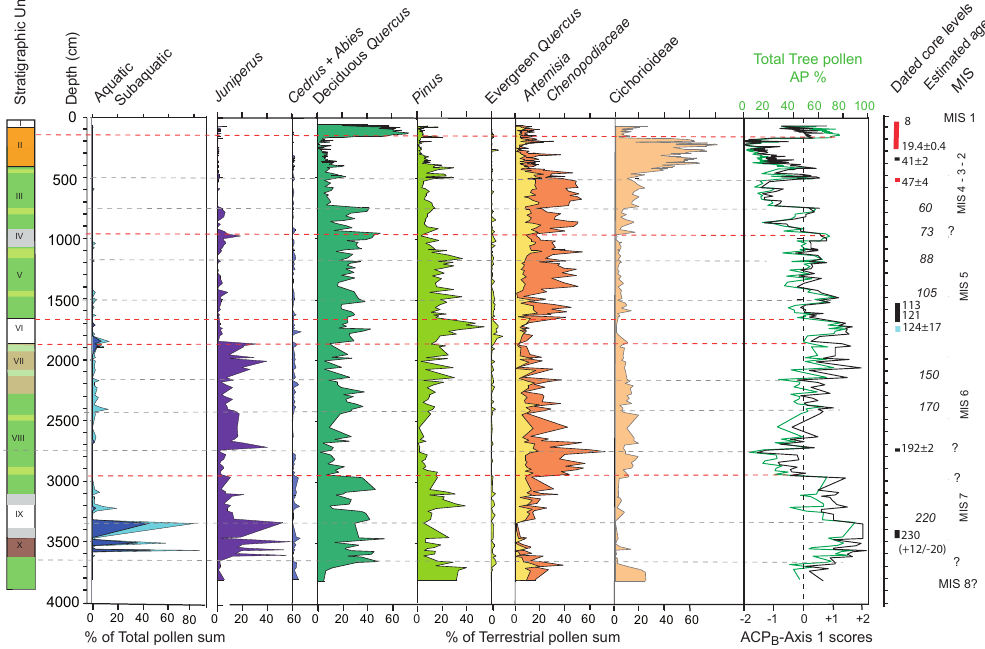
Fig. 6. Palynological data. Relative frequencies of selected pollen taxa versus depth along the stratigraphical profile, total tree pollen percentages (AP%) and ACP B -Axis 1 scores showing the alternance of forested and steppic landscapes. Chronological information as for Fig. 5. Horizontal dashed lines: major (red) and second order (grey) vegetation